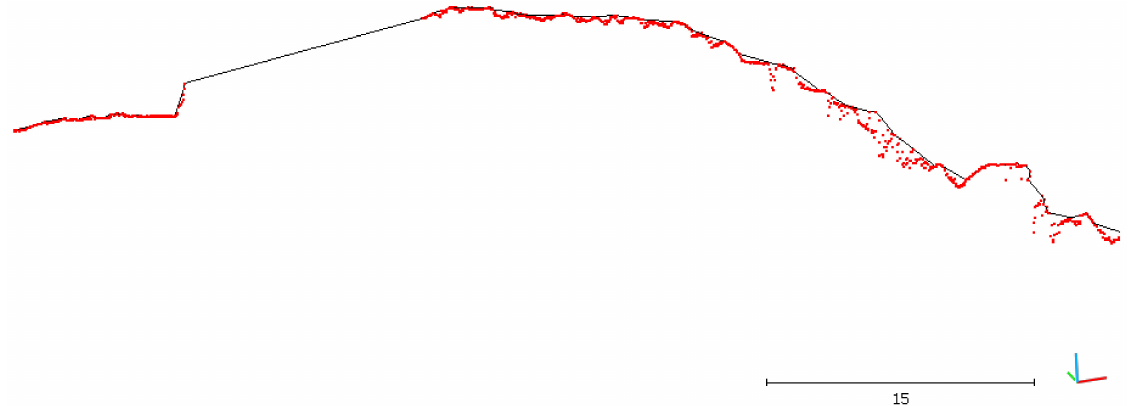
Figure 5. Profile ( black line ) and section cloud ( red points ) of a portion of a representative section on the head of the breakwater of